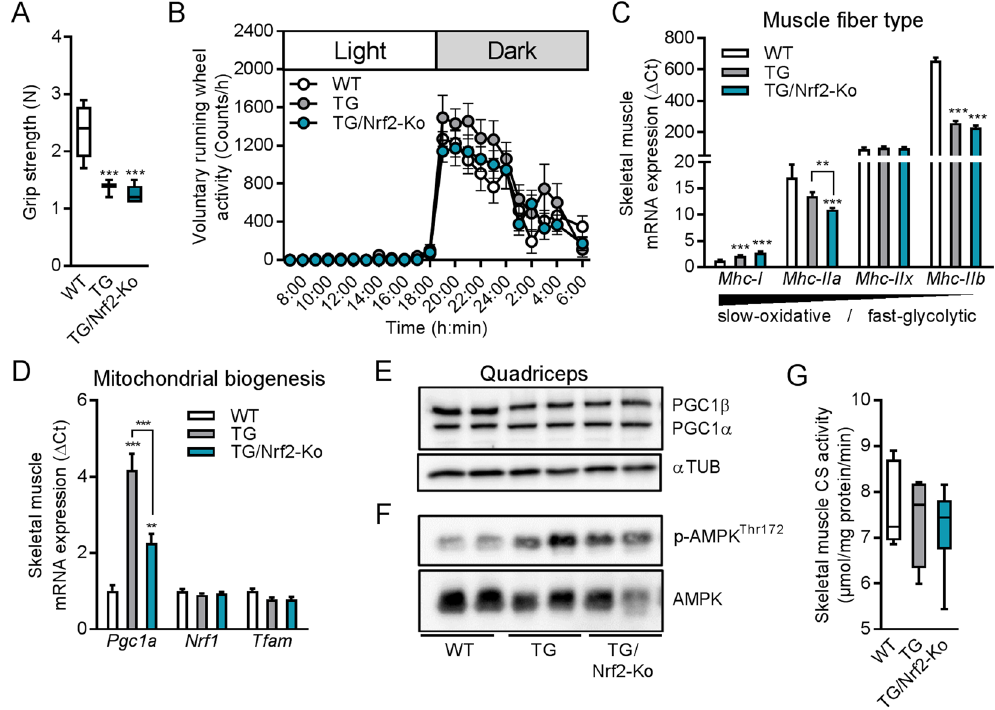
Figure 2. Skeletal muscle integrity and mitochondrial biogenesis in male TG/Nrf2-Ko mice. ( A ) Grip strength of 24 wks old animals (n = 8–10). ( B ) 24 h voluntary running wheel activity of 14 wks old male mice (n = 9–10). ( C ) Skeletal muscle mRNA expression in quadriceps muscle of the myosin heavy chain ( Mhc ) fiber type markers and ( D ) mitochondrial biogenesis markers of 24 wks old animals (n = 8–10). ( E ) Representative immunoblots of PGC1 α / β in quadriceps muscle from 24 wks old mice from cropped blots of the same gel using α Tubulin ( α TUB) as loading control (2 samples shown out of 4–5 analyzed per group). ( F ) Representative immunoblots of phospho-AMPK Thr172 and total AMPK in quadriceps muscle from 24 wks old mice from different gels processed in parallel (2 samples shown out of 4–5 analyzed per group). ( G ) Skeletal muscle (gastrocnemius) citrate synthase activity of 24 wks old animals (n = 4–8). All absolute values are expressed as box-and-whisker plots, relative or normalized data are expressed as means + SEM; ** p < 0.01; *** p <